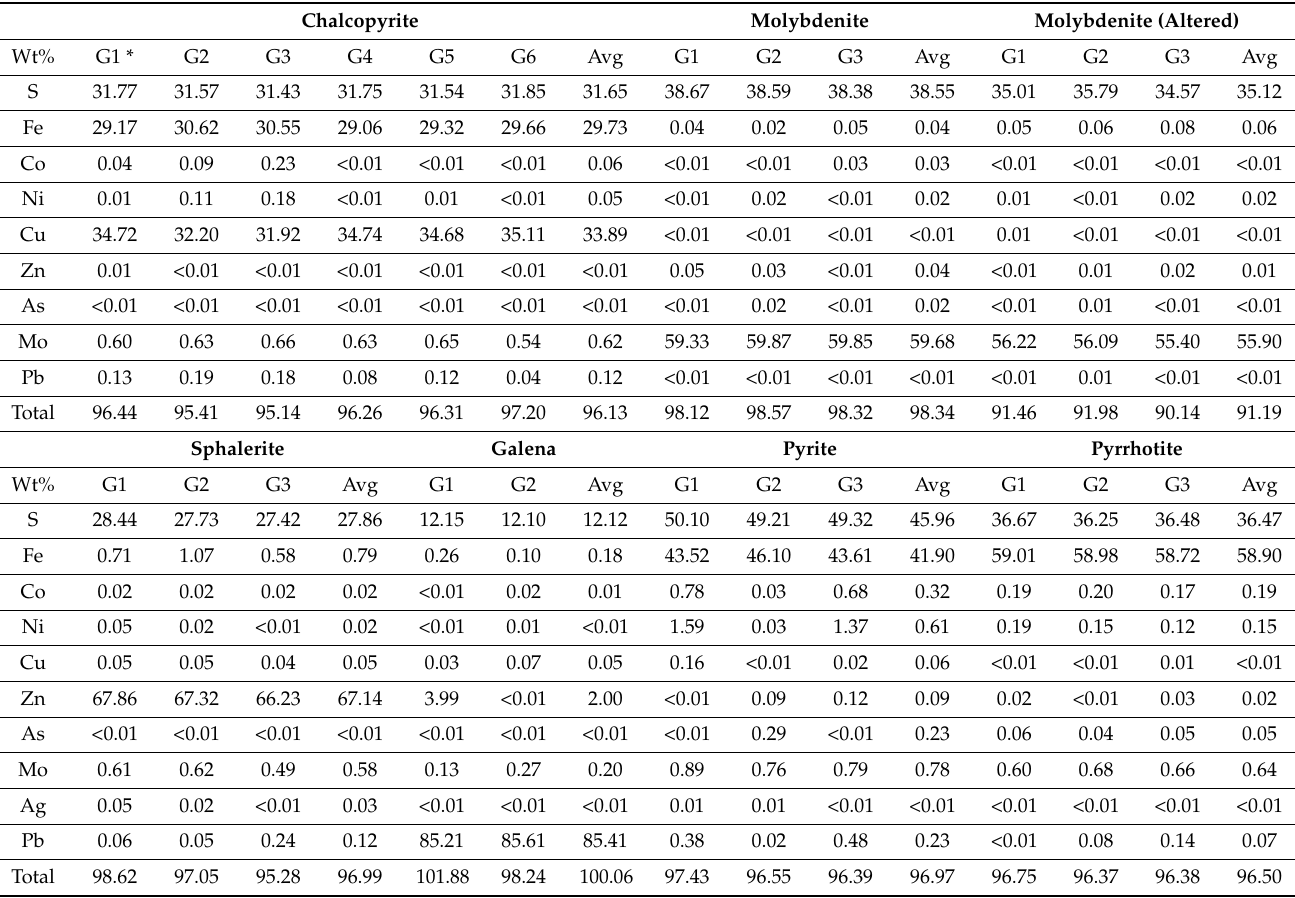
Table 4. Mineral chemistry of the sulphide phases in the polymetallic uranium deposit of Rohil. Chalcopyrite